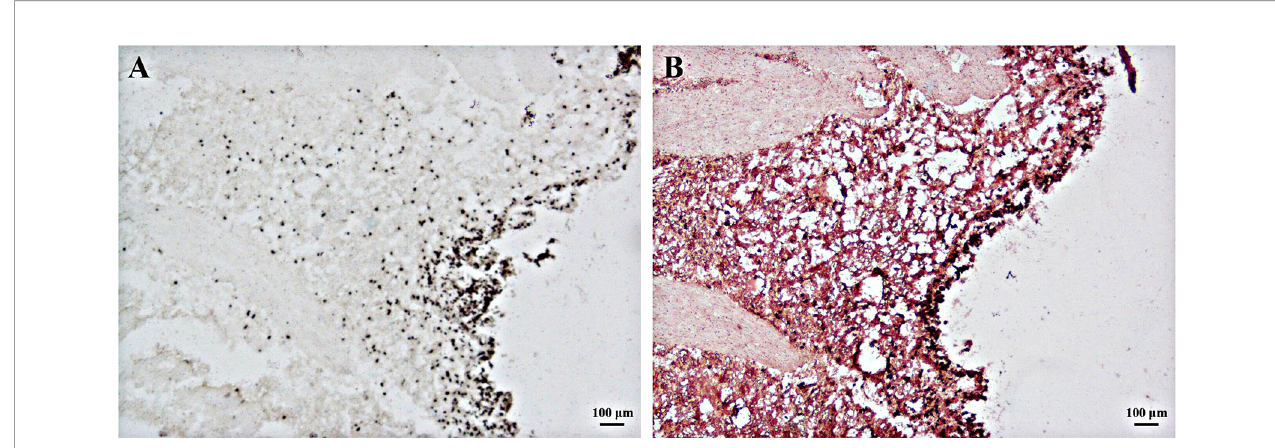
FIGURE 3 | DOPA staining of melanin in frozen-sectioned mantle tissue. (A) DOPA staining of melanin in mantle tissue with (B) and without (A) neutral red counterstaining. Brown or black particles indicate positive results. Bar, 100 m